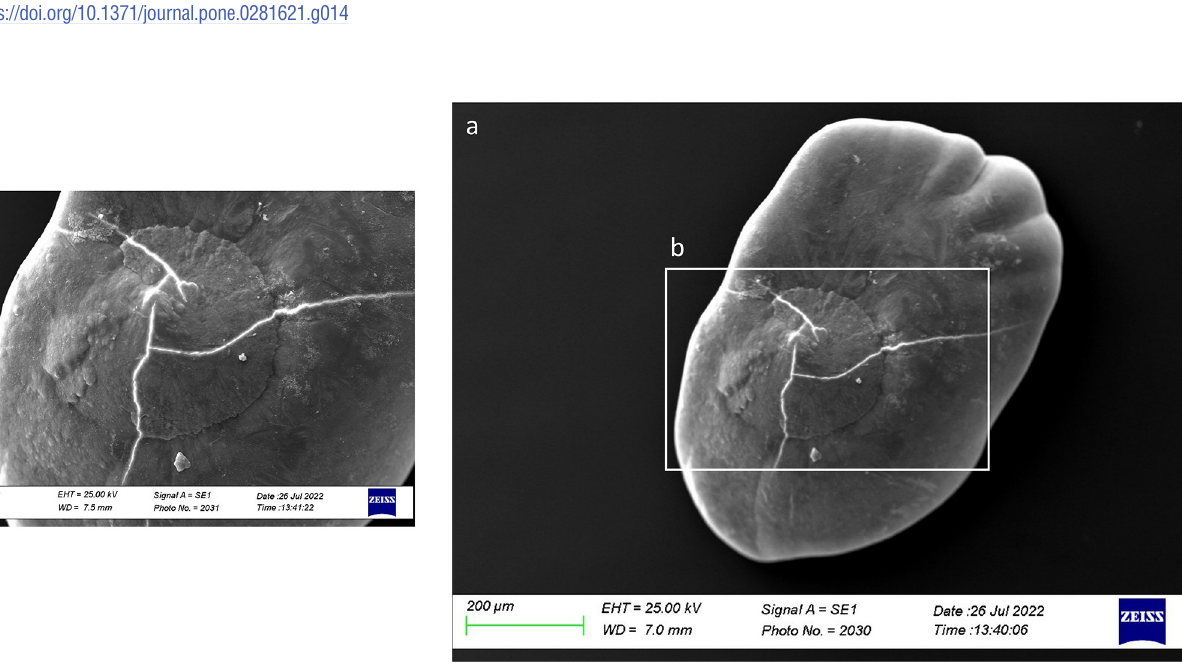
PLOS ONE | https://doi.org/10.1371/journal.pone.0281621 February 14,